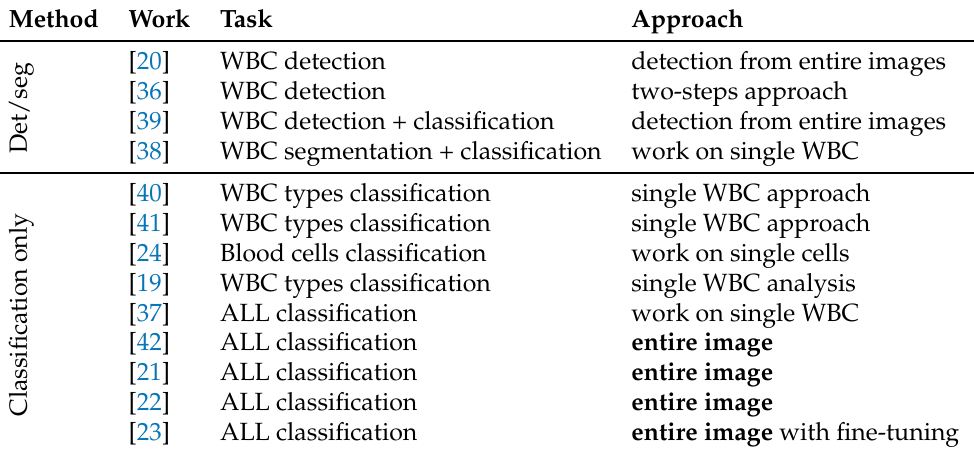
Table 1. Overview of existing works in this field with key insights from the proposed